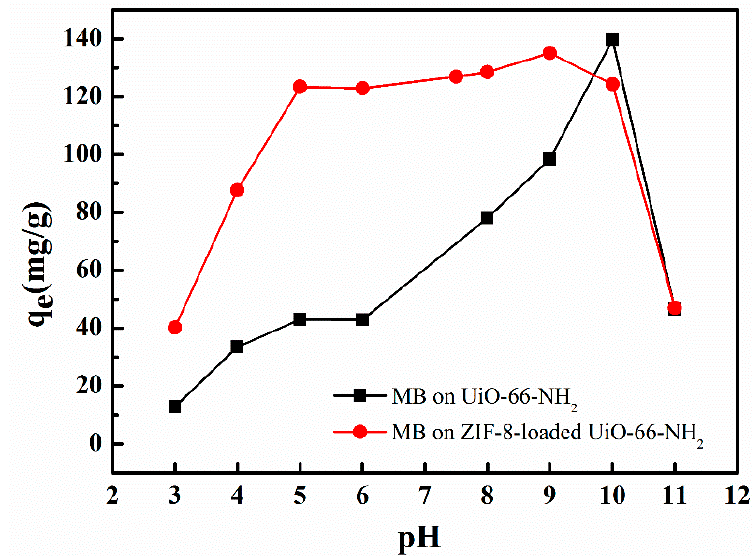
Figure 9. The e ff ect of pH on methylene blue (MB) adsorption onto UiO-66-NH 2 and zeolitic imidazolate Figure 9. The effect of pH on methylene blue (MB) adsorption onto UiO-66-NH 2 and zeolitic (ZIF-8)-loaded UiO-66-NH 2 at ambient condition (25 ◦ C). imidazolate (ZIF-8)-loaded UiO-66-NH 2 at ambient condition (25 °C).